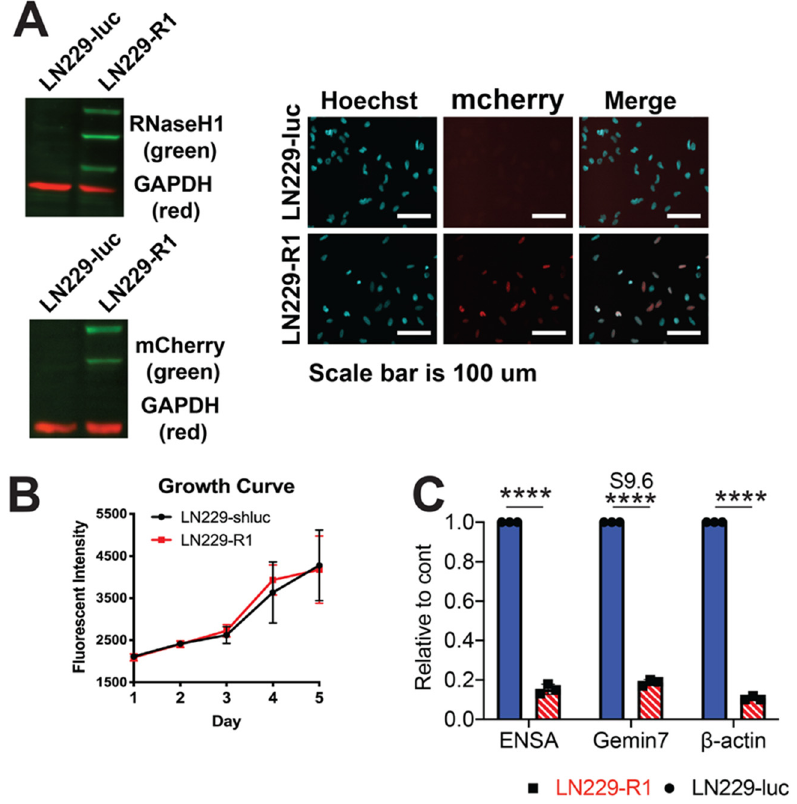
Figure 3. Human RNaseH1 can be stably expressed and is functional in LN229 glioblastoma cells. ( A ) Expression of a mCherry fused human RNaseH1 in LN229 cells was verified by Western blot analysis using antibodies targeting mCherry and RNaseH1, as well as by intracellular mCherry signal. ( B ) Cellular growth of LN229 control (LN229-luc) and RNaseH1 expressing LN229 (LN229-R1) cells was determined by fluorescent intensity over 5 days. ( C ) Chromatin immunoprecipitation/qPCR experiments were performed using the S9.6 antibody at the 3’ end of the ENSA , Gemin7 or β -actin genes in LN229-luc and LN229-R1 cells. Statistical analysis was done using Student’s t -test. **** = p < 0.0001. Detailed information about Western blot can be found at Figure